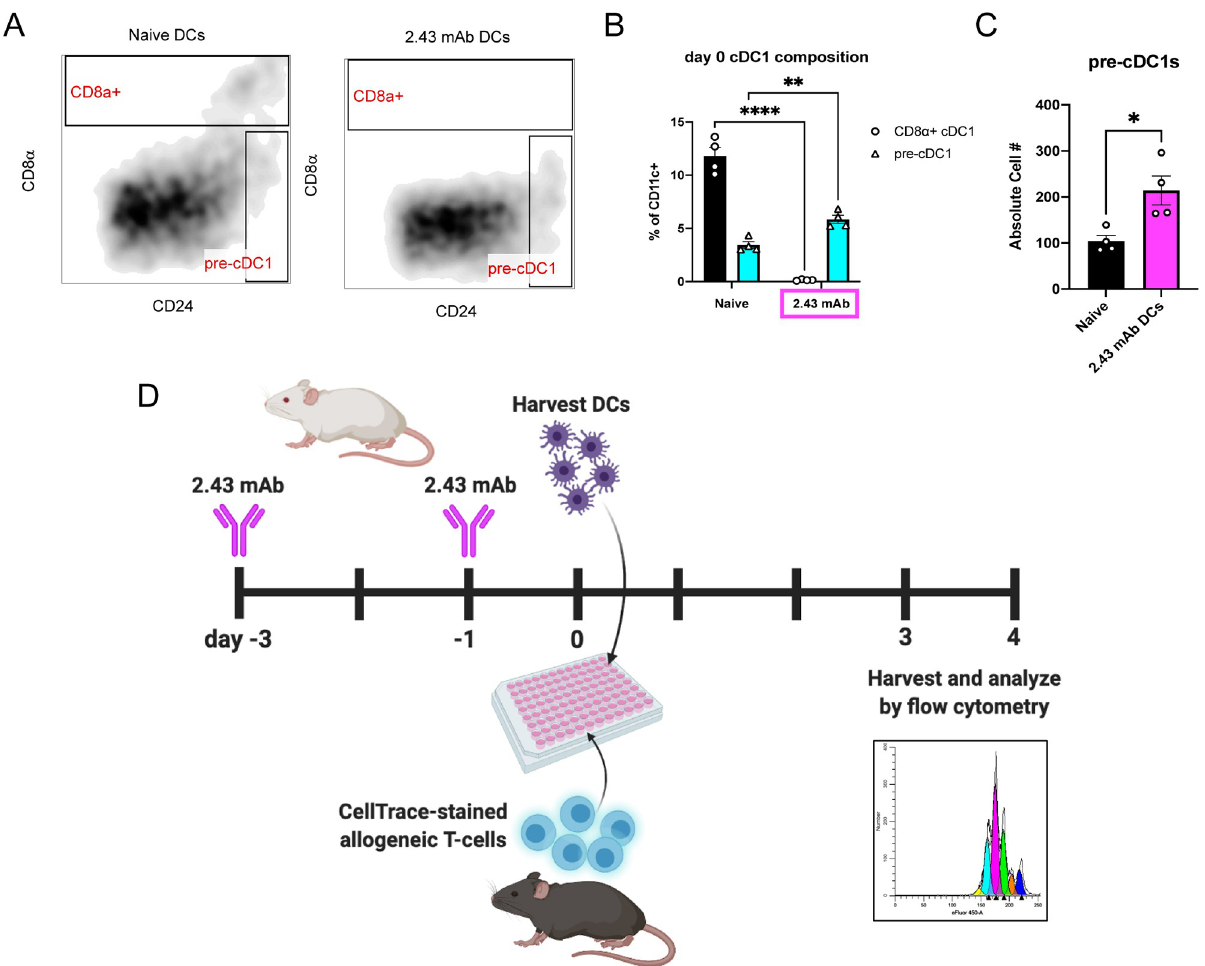
Fig 2. Using a CD8 α -depleting antibody to determine functional redundancy. BALB/c mice were dosed with 200 μ g of 2.43 mAb antibody intraperitoneally on day -3 and day -1. On day 0, splenic DCs were isolated and analyzed by flow cytometry. Data is representative of three independent experiments. (n = 4 per group) (A) Representative flow plots depicting relative cDC1 proportions in na ï ve DCs (left) and 2.43 mAb DCs (right). Gated on CD11c+B220- (conventional DCs). (B) Mean percent of CD8 α + cDC1s (black) and pre-cDC1s (cyan) in untreated and 2.43 mAb-treated DCs shown with SEM. Two-way ANOVA and Dunnett’s multiple comparisons used to determine significance. �� P < 0.01, ���� P < 0.0001. (C) Mean absolute cell number of pre-cDC1s (CD24 high CD8 α -) in untreated (black) and 2.43 mAb-treated (magenta) groups shown with SEM. Unpaired t test used to determine significance. � P < 0.05. (D) Schematic depicting experimental design for proposed allogeneic mixed leukocyte reaction (MLR) using 2.43 mAb treatment.